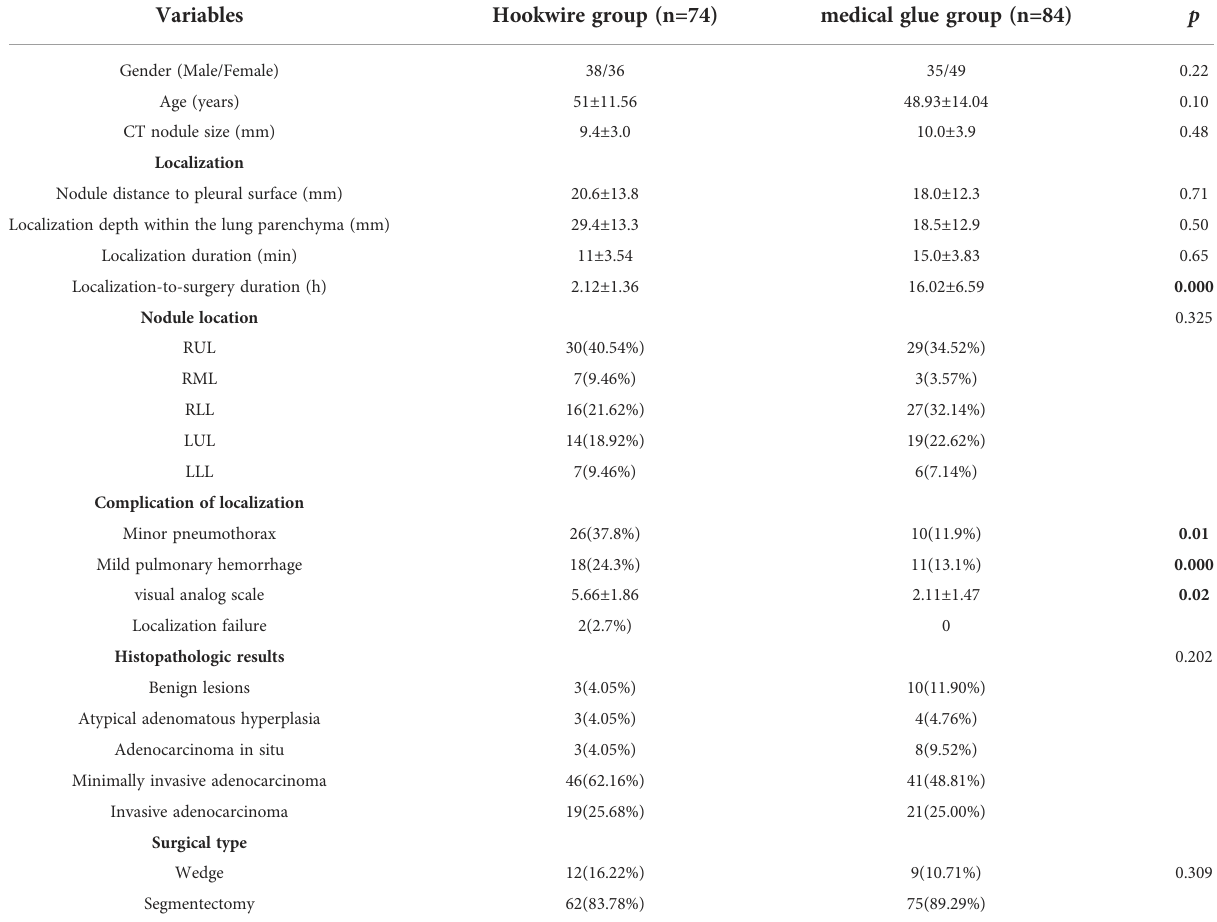
TABLE 1 Comparison of Variables between the 2